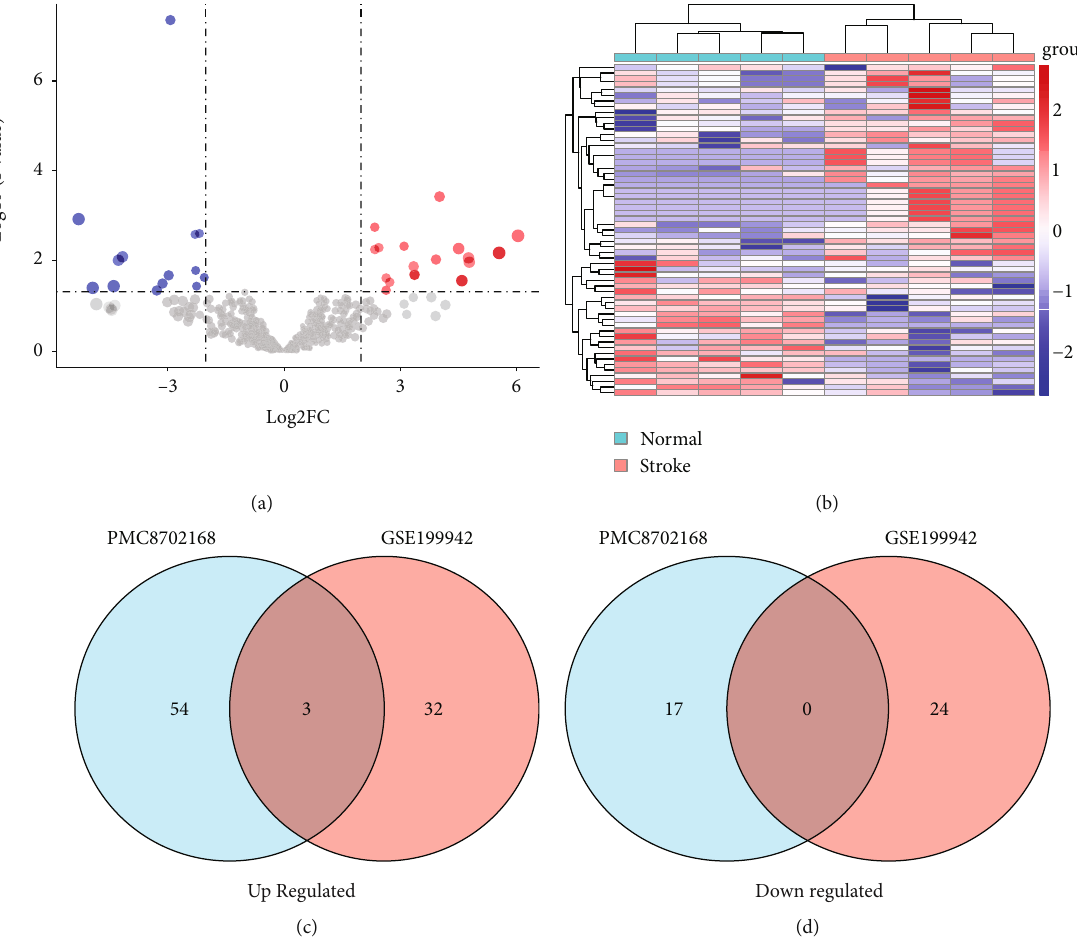
Figure 1: Scanning di ff erentially expressed miRNAs. (a) Di ff erentially expressed miRNAs in GSE199942. |LogFC| > 1 and P value < 0.05 were set to screen. (b) Heatmap of the di ff erentially expressed miRNAs in GSE199942. (c) Venn diagram representing the intersection of up- regulated expressed miRNAs in the 2 data sets (GSE199942 and PMC8702168). (d) Venn diagram representing the intersection of down- regulated expressed miRNAs in the 2 data sets (GSE199942 and